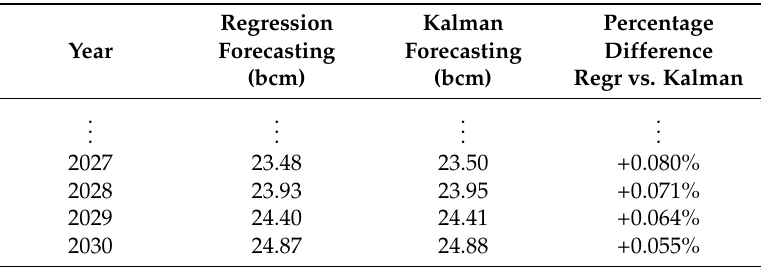
Table 4. Forecasting results. C res values. Standard regression compared to Kalman filter forecasting. The percentage differences are reported in the last column.